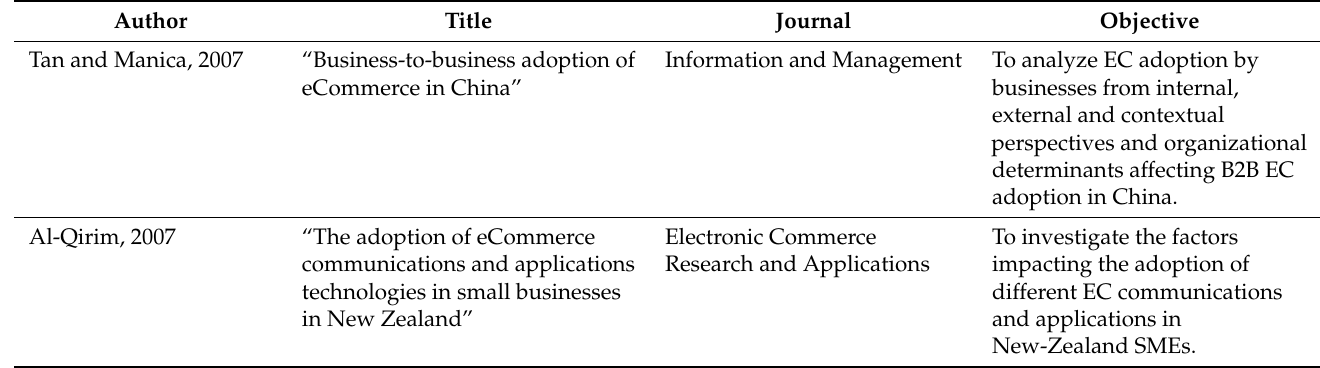
Table 2. Articles regarding the dimension of transition towards